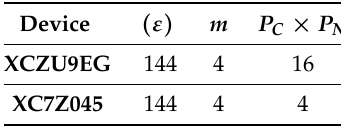
Table 5. Parameters for